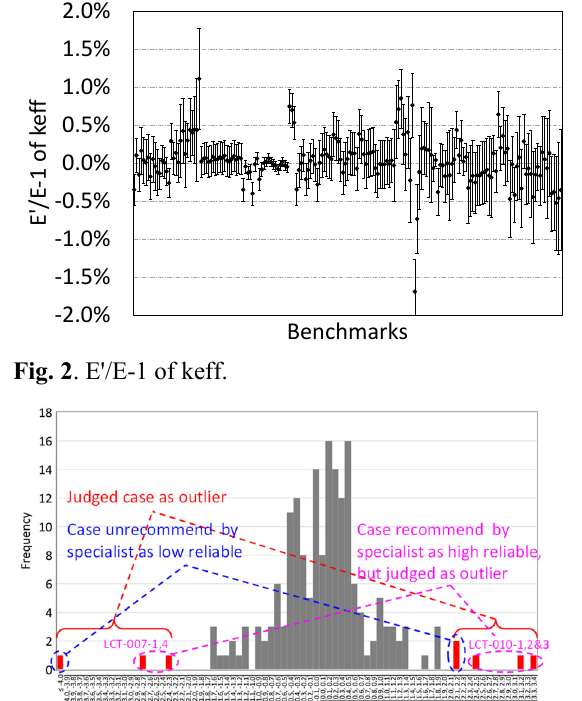
Fig. 3 . Histogram of “normalized E'/E-1 by uncertainty of E'/E-1” to judge outlier